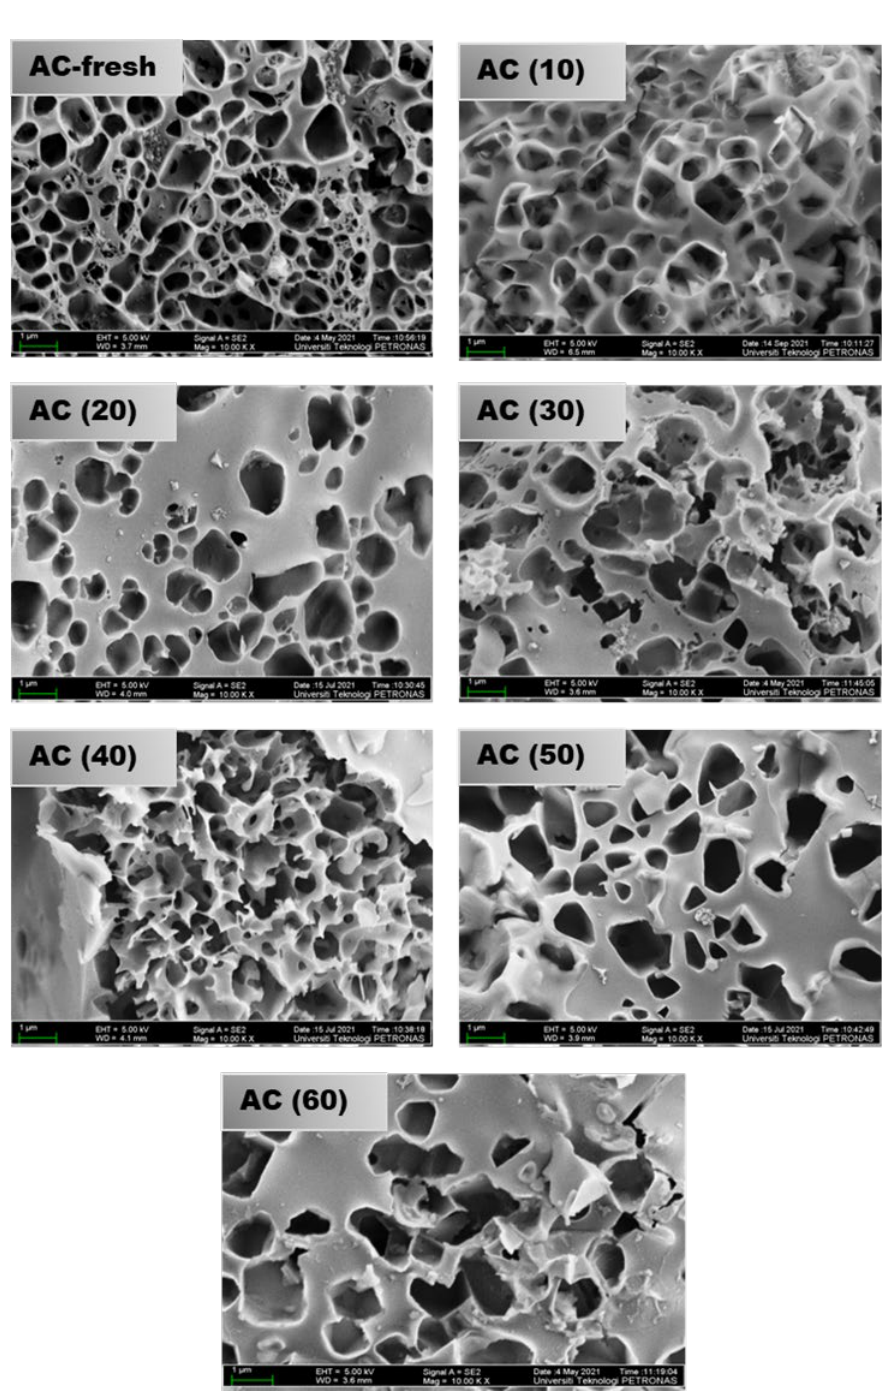
Figure 3. FESEM images of fresh activated carbon (AC) and functionalized with different concentra- tions of IL obtained at 1 µ m (10,000 × magnification